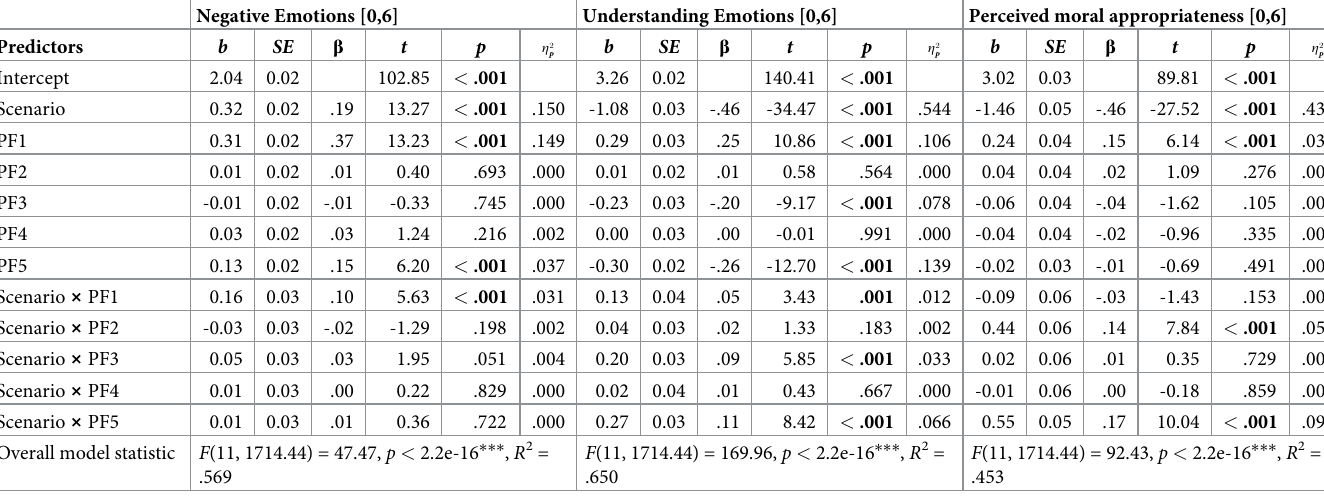
Table 4. Results of linear mixed effect regressions for observers’ emotional and cognitive responses (N = 1004). Negative Emotions [0,6] Understanding Emotions [0,6] Perceived moral appropriateness [0,6]